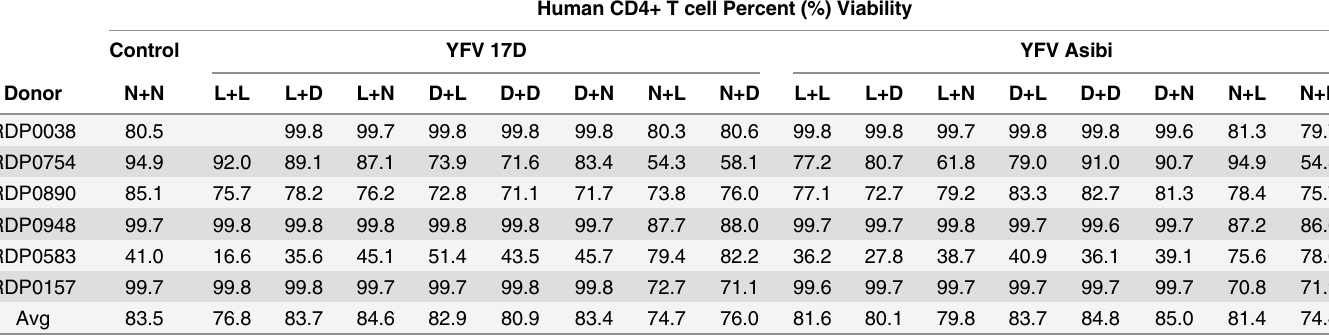
Table 1. CD4 + T cell viability following co-culture with MoDC.